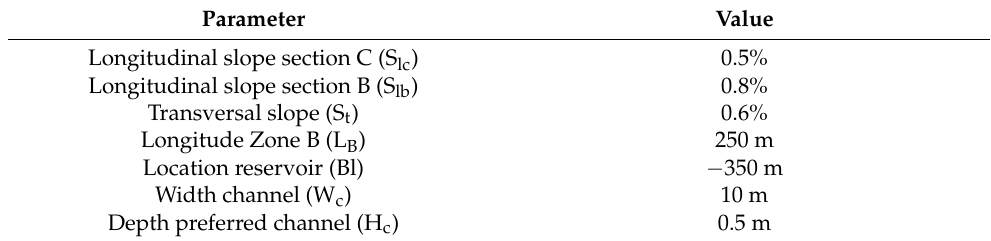
Table 7. Terrain parameters El Rubial.